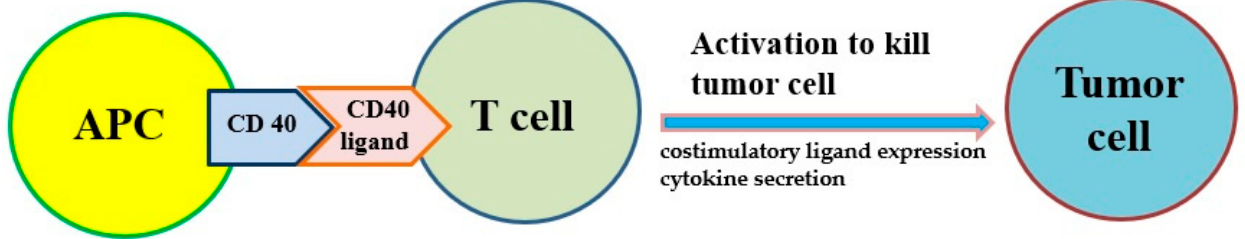
Figure 2. The costimulatory receptor CD40 on antigen-presenting cells (APCs) can improve the antitumor response of T cells because it induces costimulatory ligand expression and cytokine secretion that drive antitumor activity.